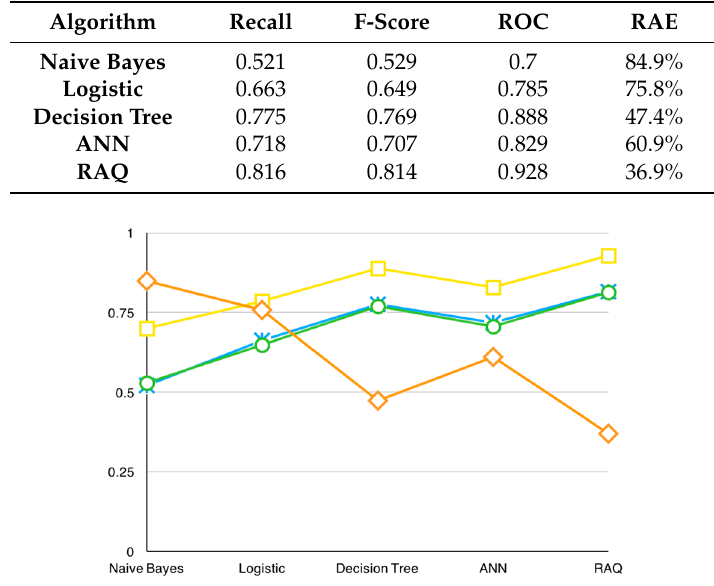
Figure 13. Indexes chart of different algorithms.